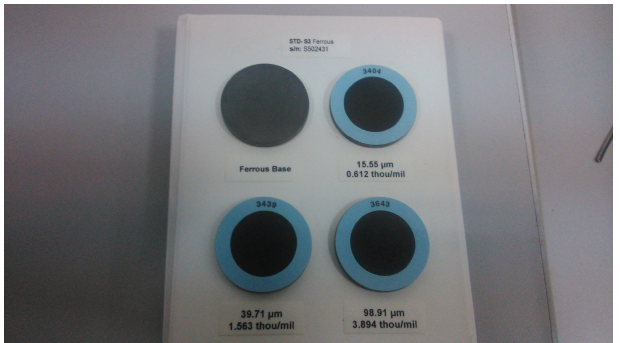
Figure 5. The Certified Reference Materials utilized for the validation of the proposed theoretically- designed transmission line model.